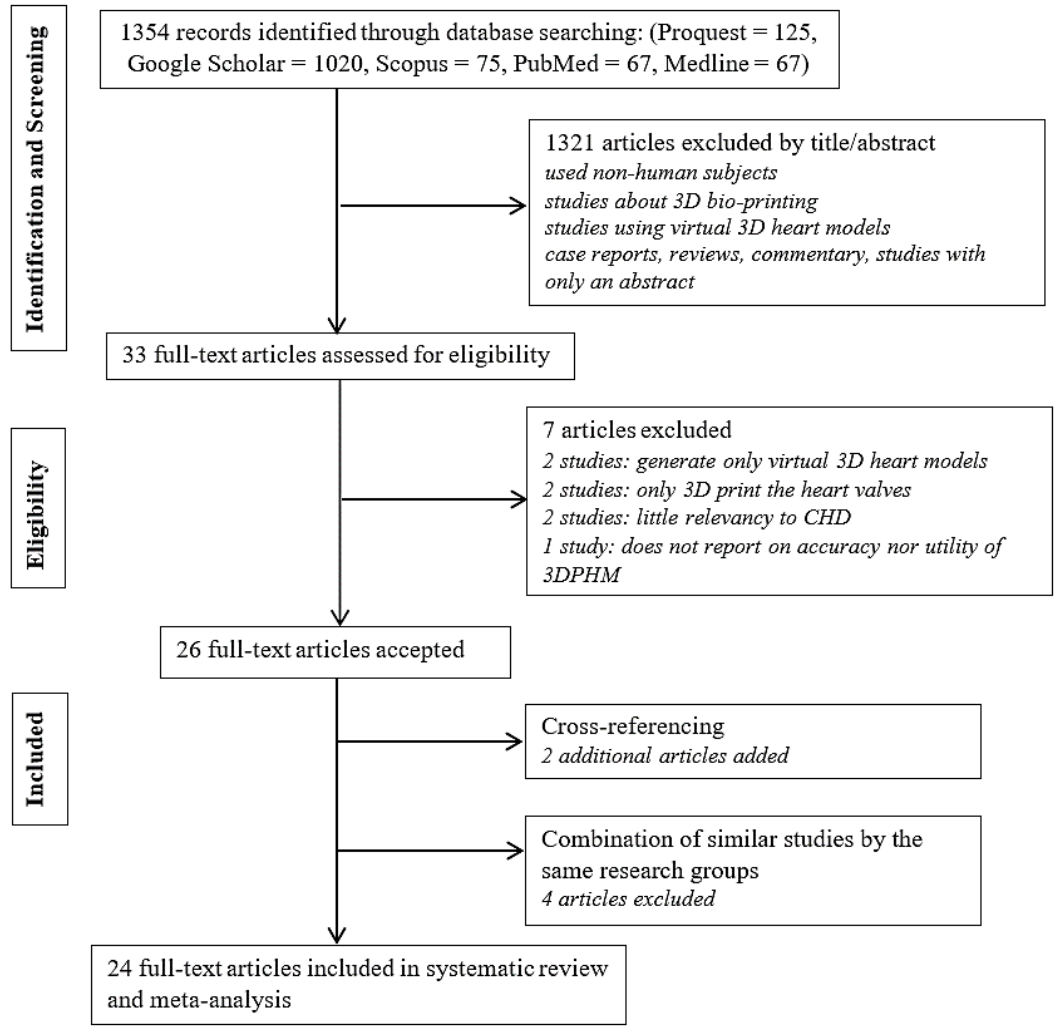
Figure 1. Flow chart of the study selection process. 3D, three-dimensional; 3DPHM, three-dimensional printed heart models; CHD, congenital heart disease.